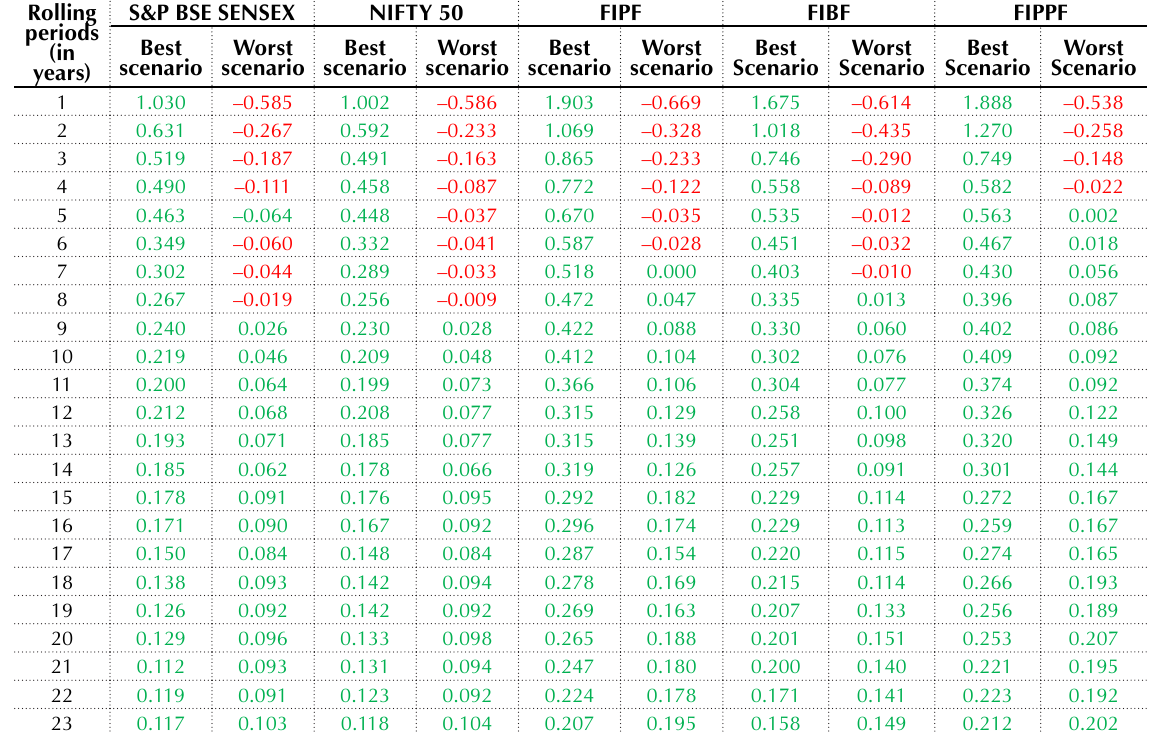
Table 4. Rolling period CAGR (in %) for S&P BSE SENSEX, NIFTY 50, FIPF, FIBF & FIPPF schemes (from 1995 to 2018)